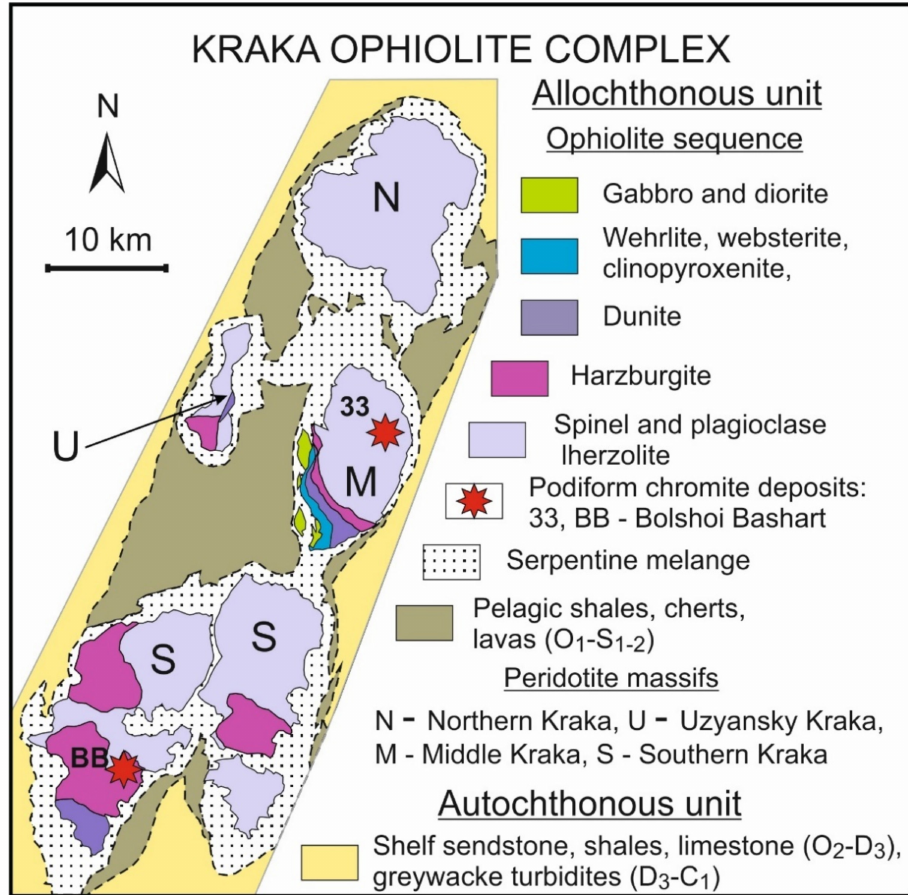
Figure 2. Simplified geological map of the Kraka ophiolite massif, showing the locations of the chromite deposits of Bolshoi Bashart (BB) and Prospect 33 (33). Modified after